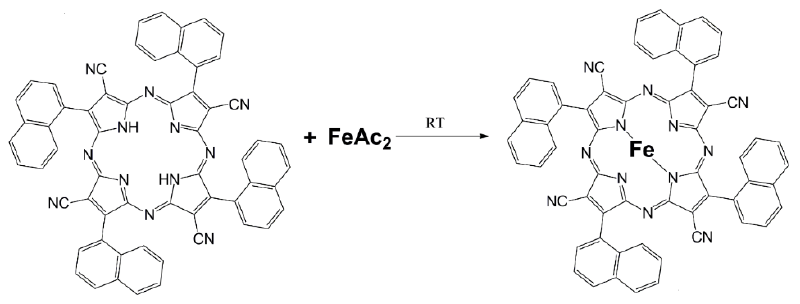
Figure 1. Scheme for the synthesis of FePzNPh from PzNPh .